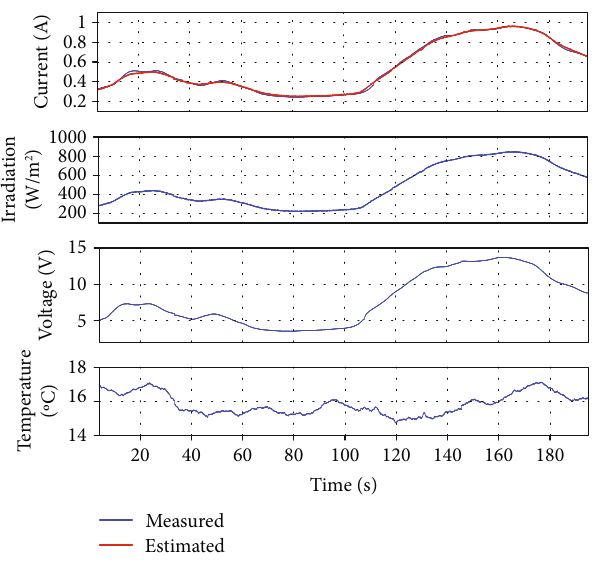
Figure 6: Model validation under natural conditions.